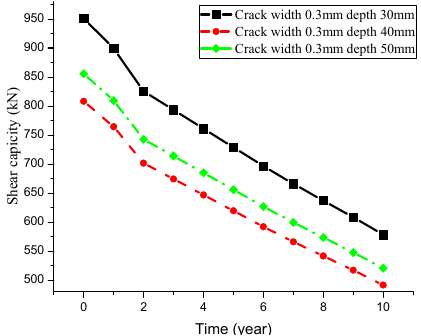
Figure 13. Shear strength attenuation curve.